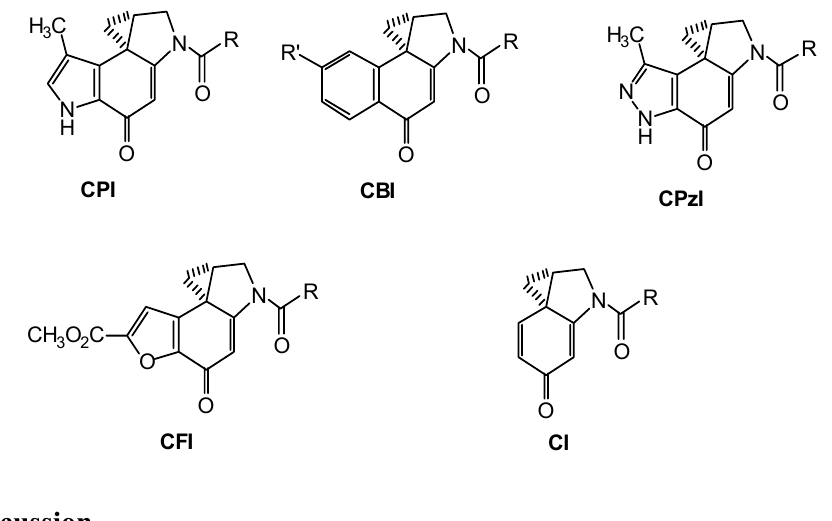
Figure 2. Strucutres of the cyclopropylpyrrolo[e]indolone (CPI), cyclopropylbenzo- [e]indolone (CBI), cyclopropylpyrazolo[e]indolone (CPzI), cyclopropylfurano[e]- indolone (CFI), and cyclopropylindolone (CI)